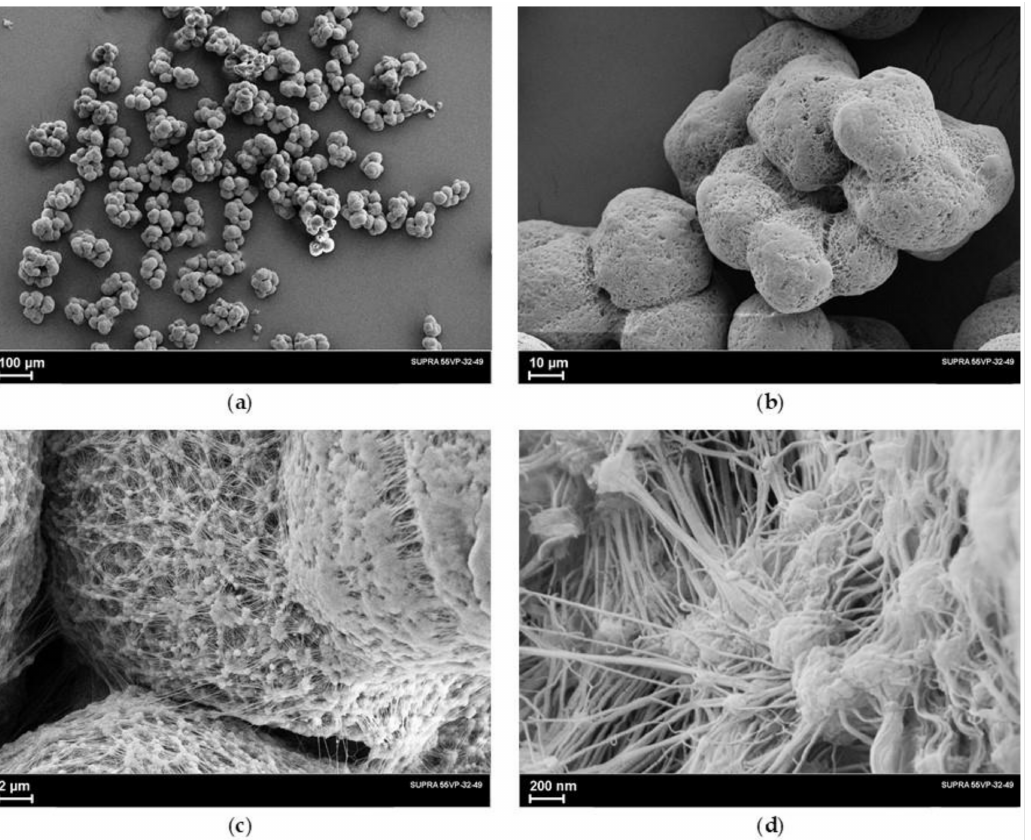
Figure 1. SEM micrographs of the UHMWPE reactor powder taken at different magnifications ( a – d